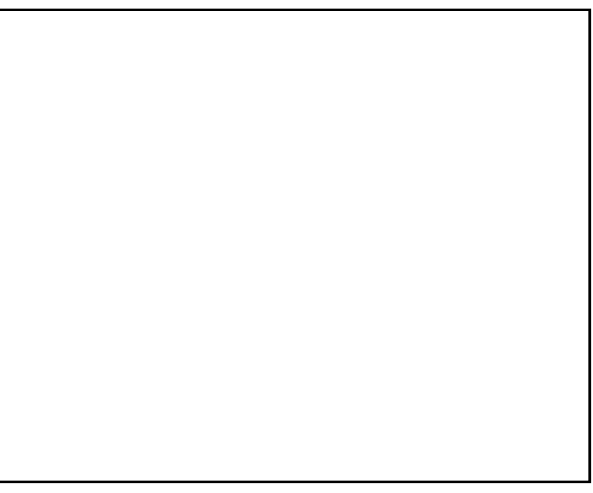
Fig.4 : Patient one month postoperative with healed corneal ulcer.